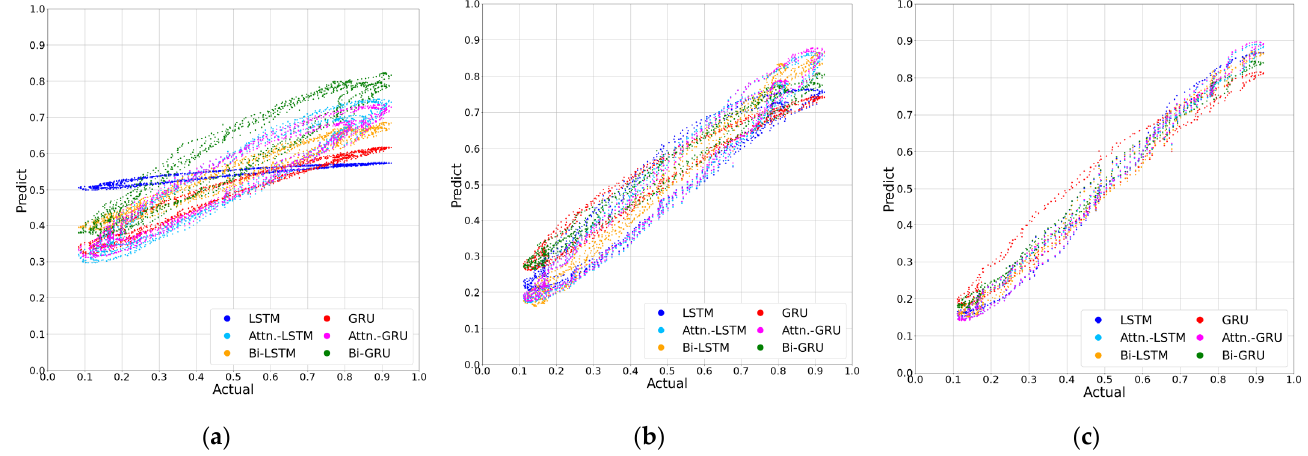
Figure 11. Scatter plots of normal vibrations: ( a ) 40%, ( b ) 60%, ( c ) 80% segment of training data.